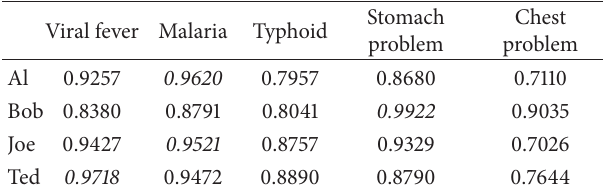
Table 3: Values of 𝜌 for each patient to the considered set of DHFS 1 possible